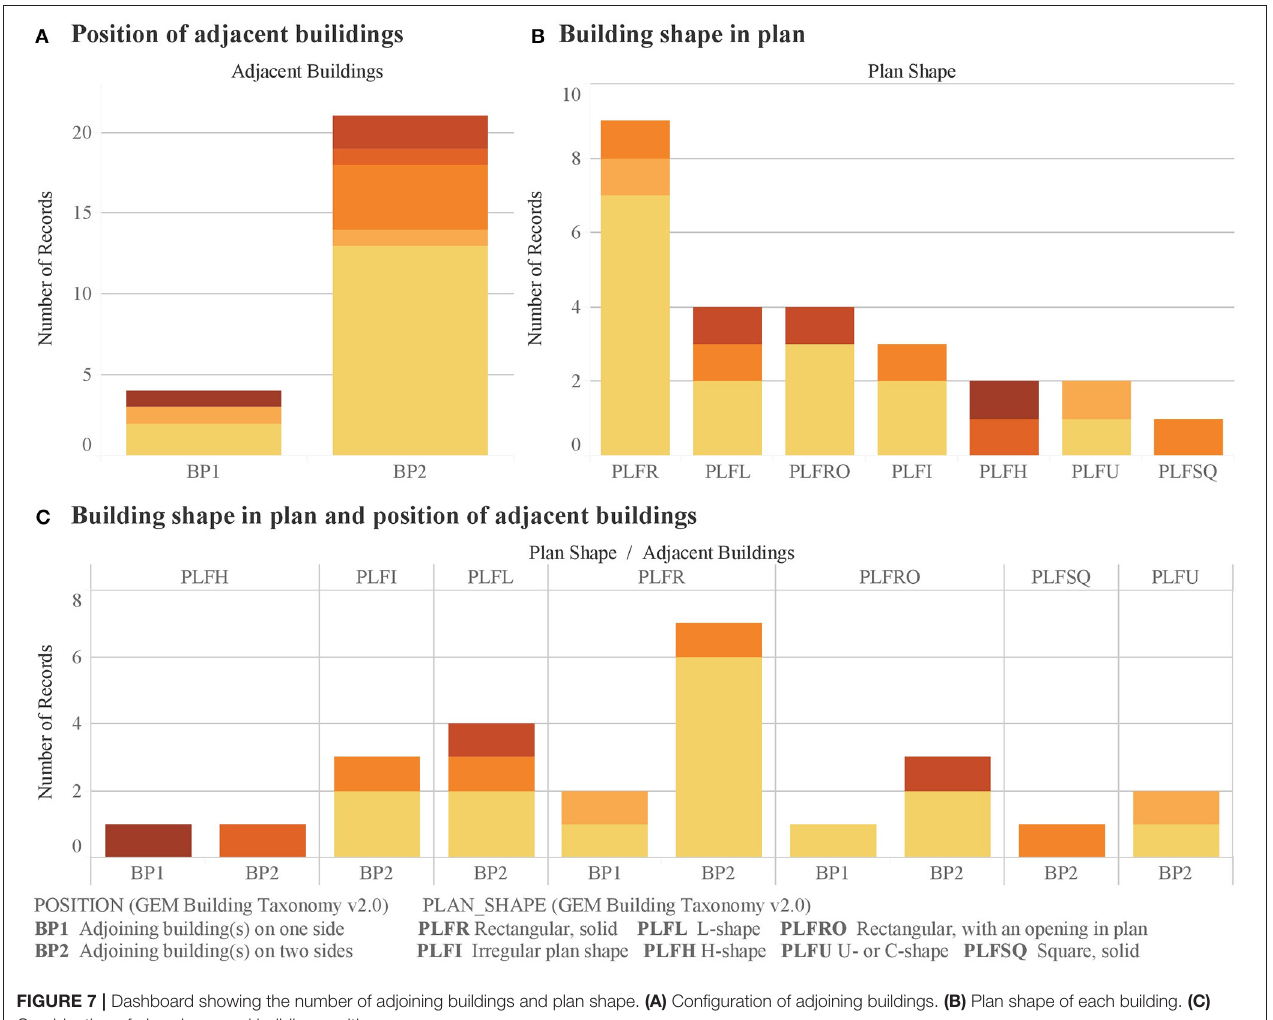
FIGURE 7 | Dashboard showing the number of adjoining buildings and plan shape. (A) Configuration of adjoining buildings. (B) Plan shape of each building. (C) Combination of plan shape and building position.